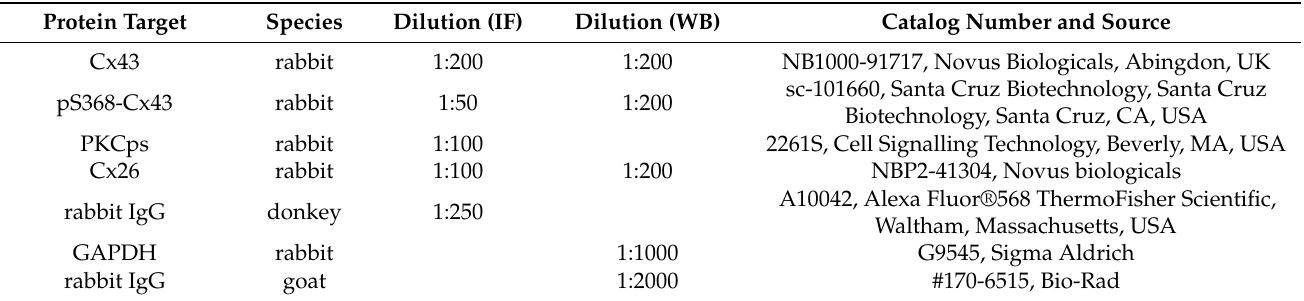
Table 3. Antibodies used in this